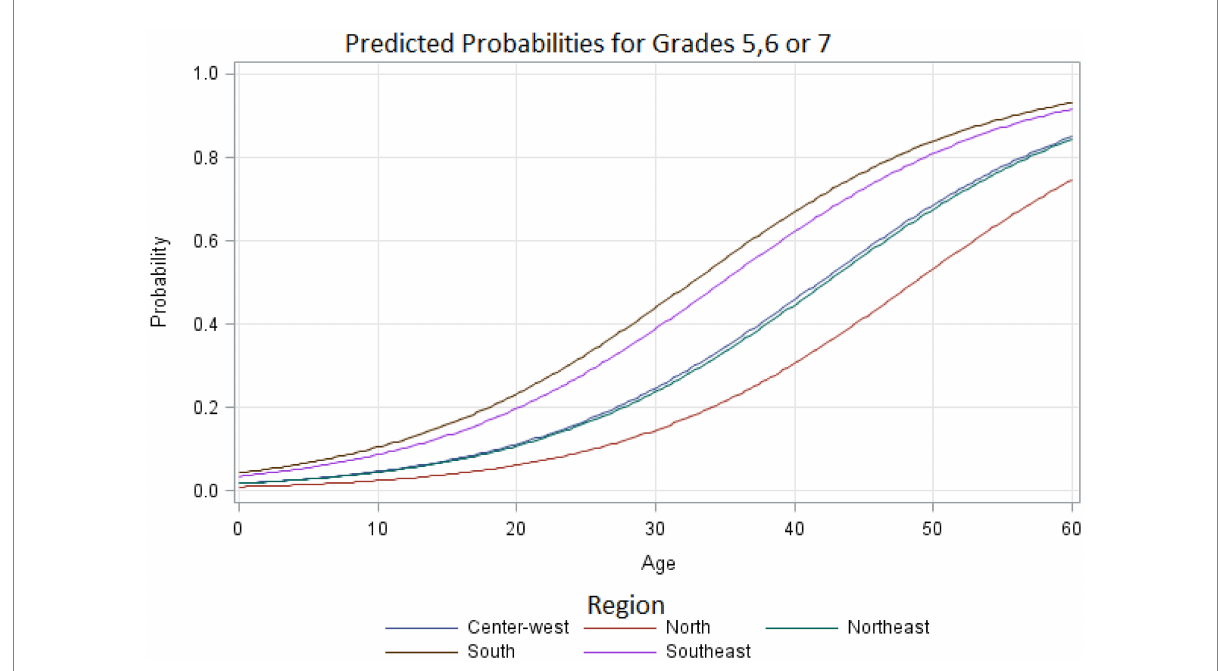
FIGURE 8 Logistic regression for probability of a postgraduate program receiving grades 5, 6 or 7 (Score 1) depending on the age of the